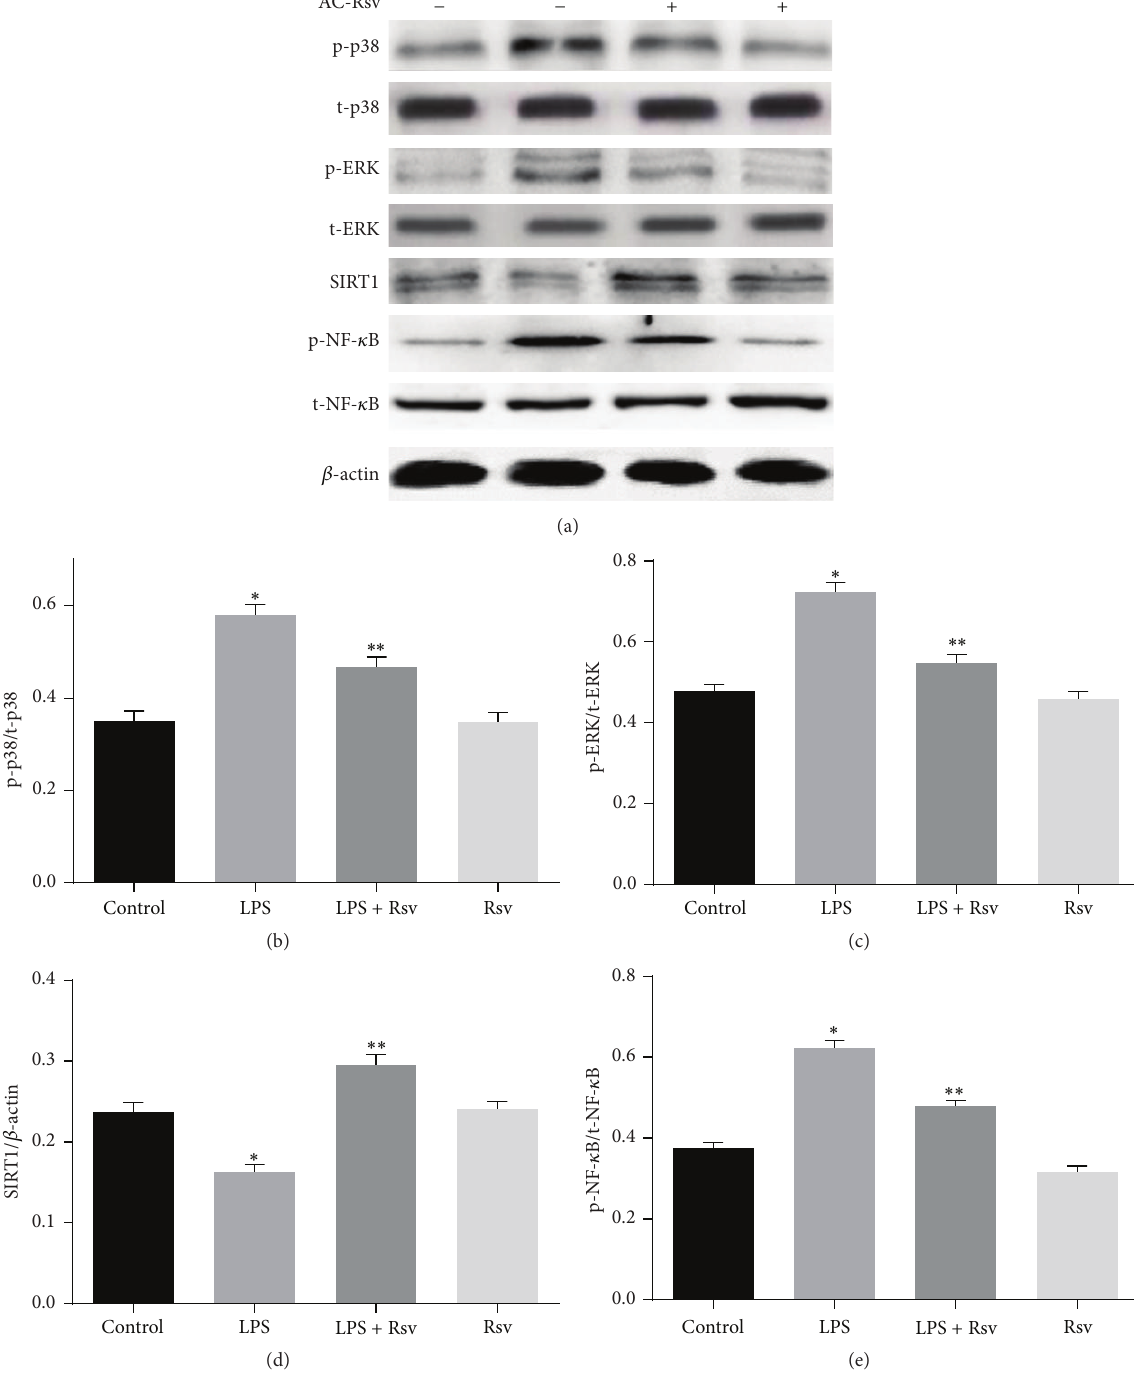
Figure 7: Effects of Rsv on the expression of MAPK/SIRT1 pathway in NR8383 cells stimulated by LPS. Relative expression levels of p-p38 MAPK, p-ERK, and p-NF- 𝜅 B were normalized to the expression levels of their total forms; SIRT1 expression was expressed by comparing with that of 𝛽 -actin. Stimulation of LPS significantly decreased the SIRT1 expression and increased the expression of p-p38 MAPK, p-ERK, and p-NF- 𝜅 B in NR8383 cells compared with that of control, ∗ 𝑃 < 0.05 versus control, while Rsv treatment dramatically decreased p-p38 MAPK, p-ERK, and p-NF- 𝜅 B expression and enhanced the expression of SIRT1 in NR8383 cells when challenged by LPS. ∗∗ 𝑃 < 0.05 versus ∗ 𝑃